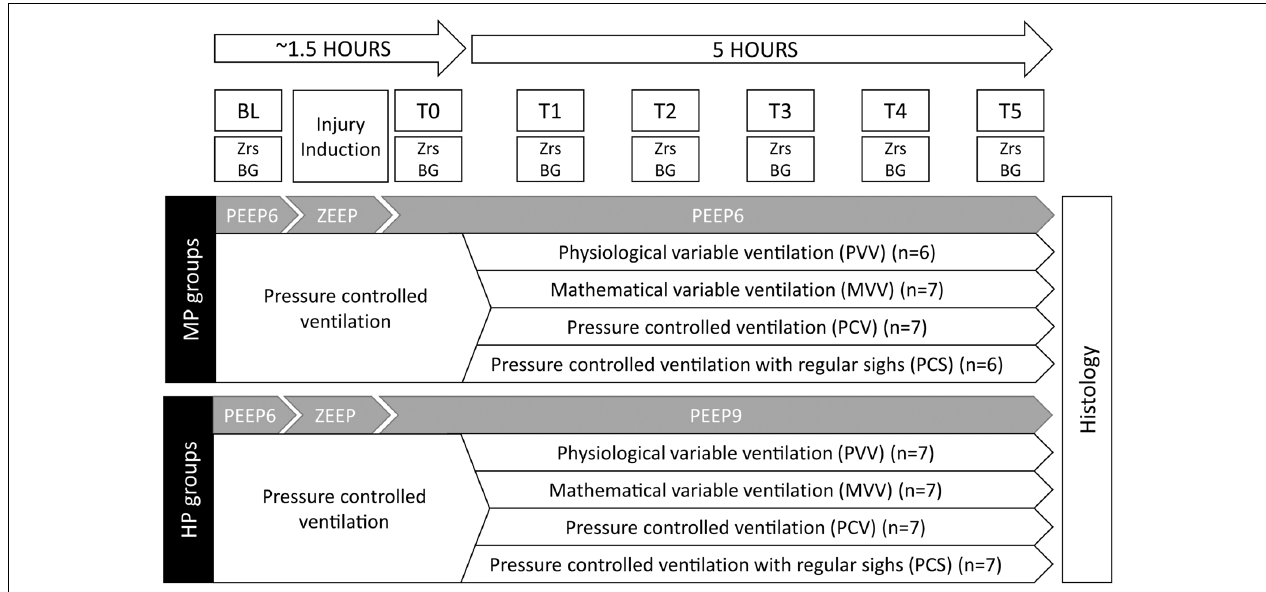
FIGURE 1 | Overview of the experimental protocol. BL, baseline; T0, measurement point following lung injury but preceding the application of various ventilation modes; T1–T5, measurement points at the end of each 5 h of ventilation with an experimental pattern; Zrs, respiratory impedance data collection; BG, blood gas measurement; PEEP, positive end-expiratory pressure; ZEEP, zero end-expiratory pressure; MP, moderate PEEP; HP, high